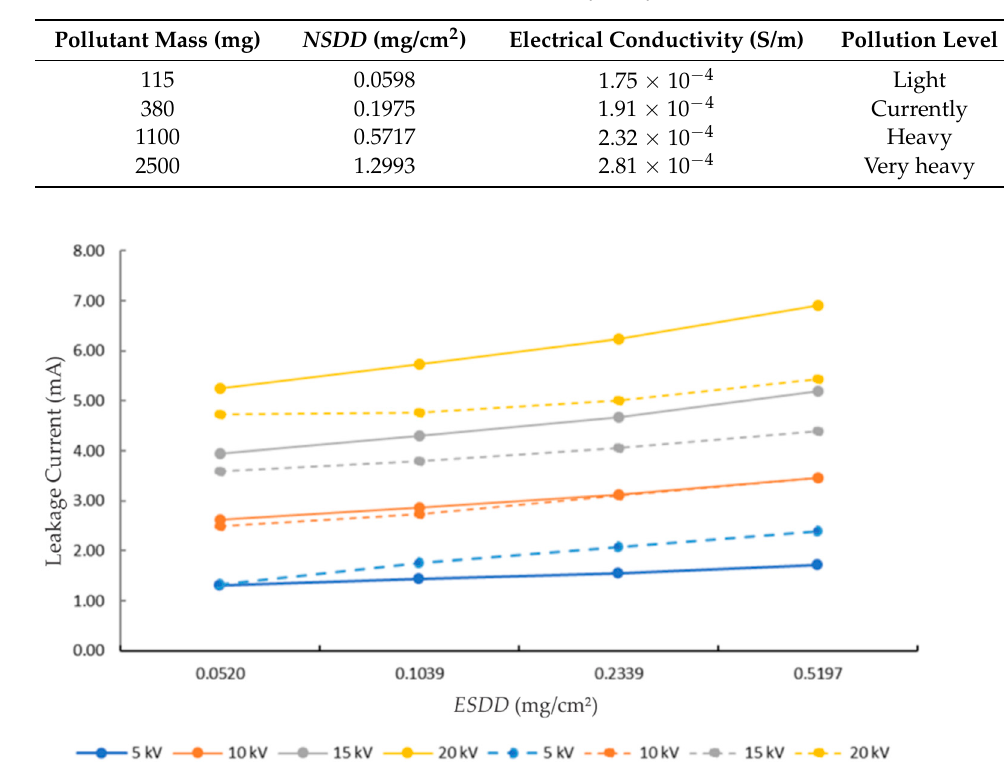
Table 4. Determination of mass, NSDD , and conductivity of fly ash.